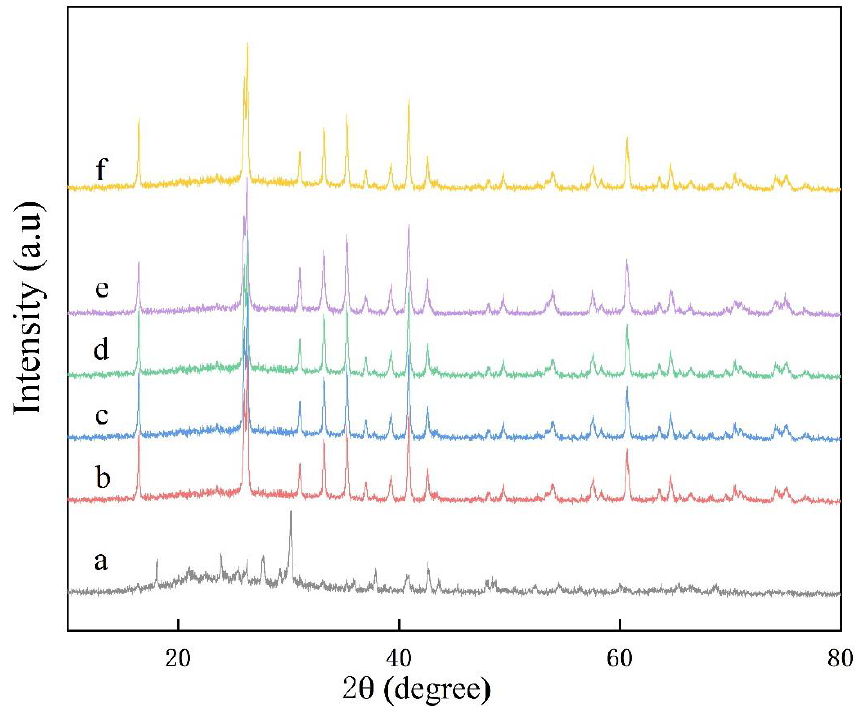
Figure 16. XRD patterns of samples containing 5% aluminum fluoride and 10% sodium sulfate mol- ten salt sintered at 825 °C; (a) holding time is 0 h; (b) 1 h; (c) 2 h; (d) 3 h; (e) 4 h; (f) 5 h. molten salt sintered at 825 ◦ C; (a) holding time is 0 h; (b) 1 h; (c) 2 h; (d) 3 h; (e) 4 h; (f) 5